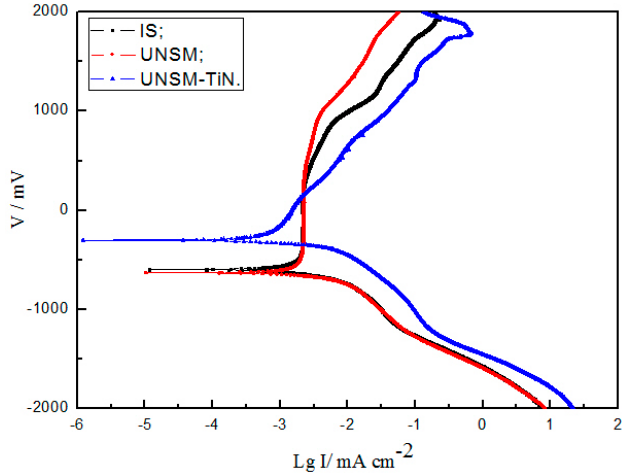
Figure 6. Polarisation curves in simulated body fluid (SBF) solution.